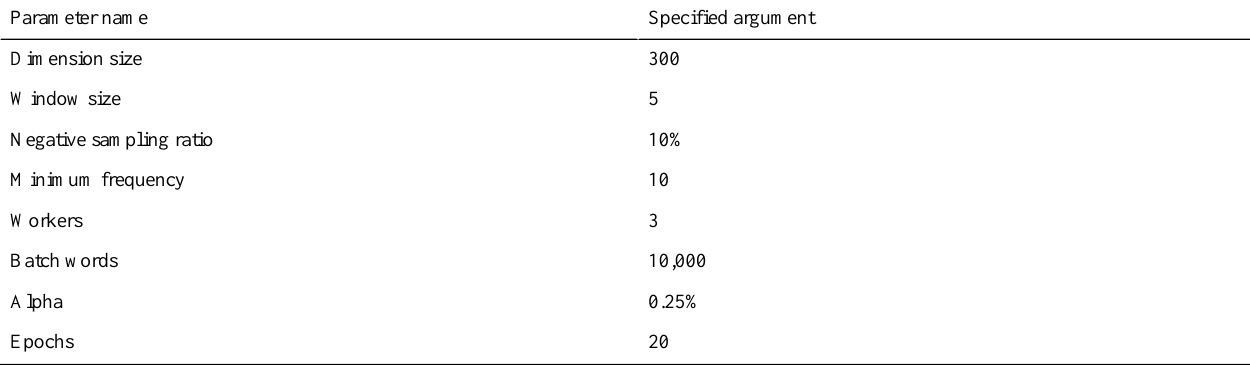
Table 2. Hyperparameters of Word2Vec and